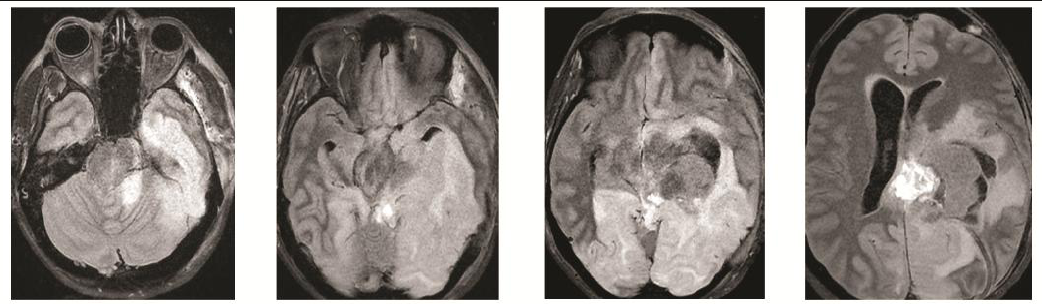
Figure 6. Final MRI on post-operative day 10 obtained demonstrated extensive infarcts secondary to vasogenic edema.